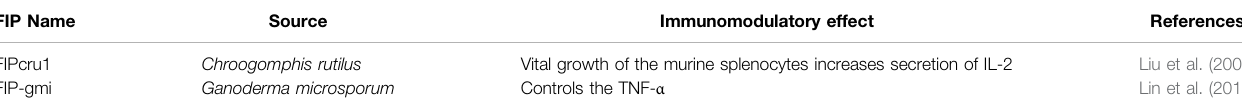
TABLE 3 | The immunoregulatory effects of FIPs found in medicinal